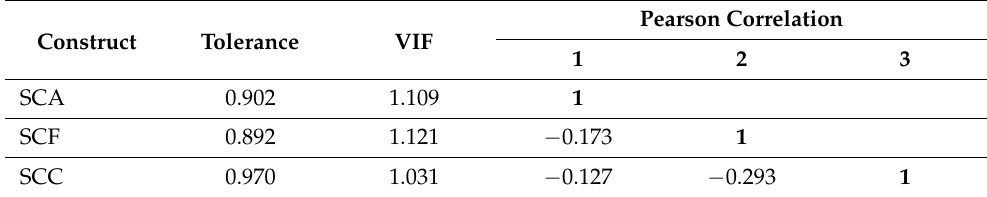
Table 9. Multicollinearity tests (N =